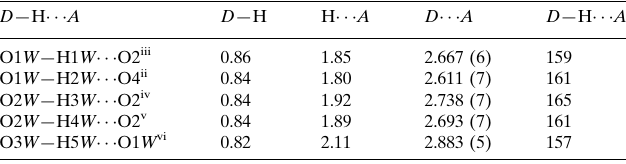
Hydrogen-bond geometry (A˚ , (cid:5)